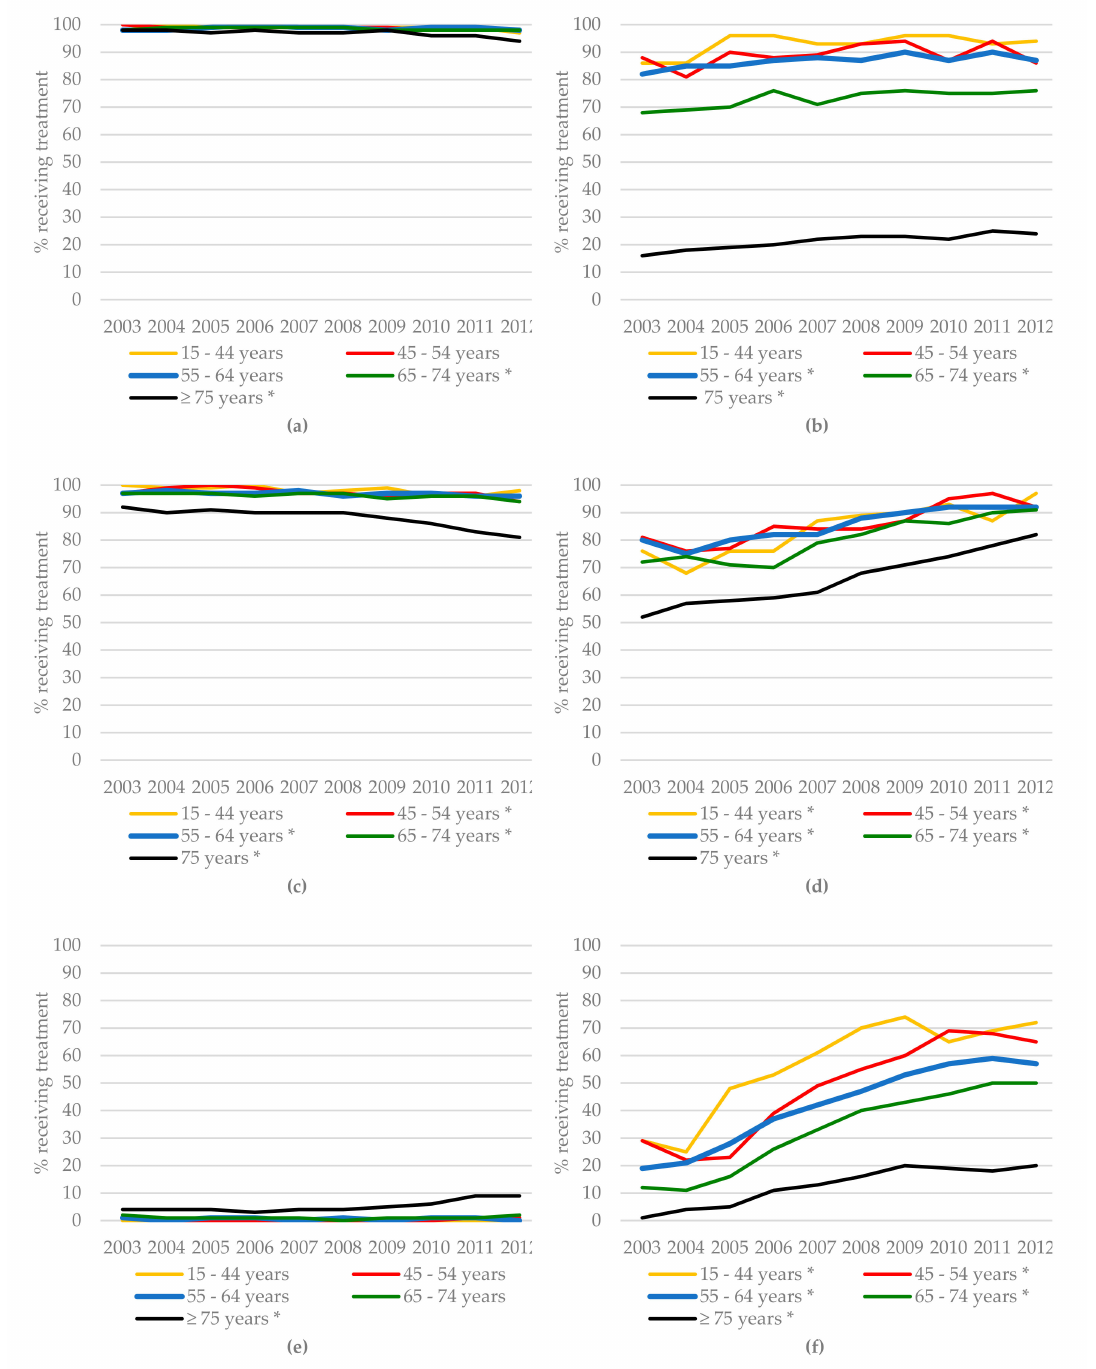
Figure 3. Time trends of treatment in colon cancer (CC) and rectal cancer (RC) patients according to age group: ( a ) surgery in CC patients stages I–III, ( b ) chemotherapy in CC patients stage III, ( c ) surgery in RC patients stages I–III, ( d ) radiotherapy in RC patients stage III, ( e ) primary radiotherapy as a single treatment modality in RC patients stage III, and ( f ) chemoradiation in RC patients stages II–III. * Significant ( p < 0.05) di ff erence in treatment over time using the Cochran–Armitage trend